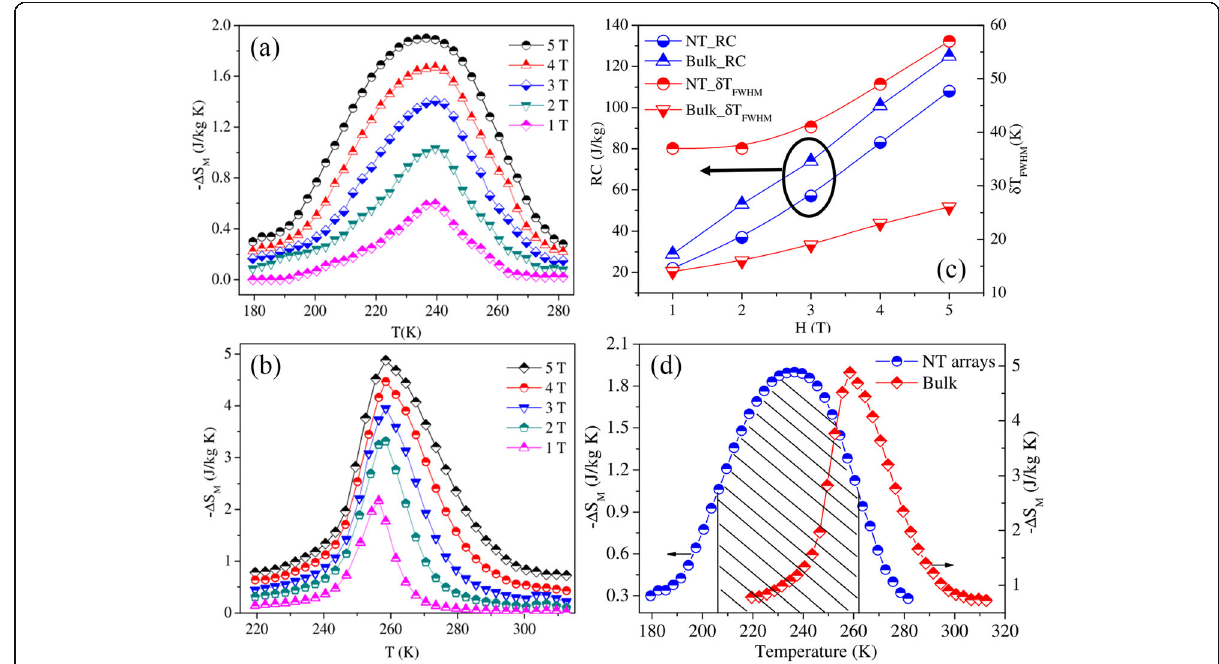
Fig. 30 Temperature dependence of − Δ S M curves for a La 0.7 Ca 0.3 MnO 3 (LCMO) nanotube (NT) arrays and b LCMO bulk at different fields. c RC and δ T FWHM with respect to the field of the LCMO NT arrays and LCMO bulk sample. d Temperature dependence of arrays and bulk at 5 T. Reproduced with permission of